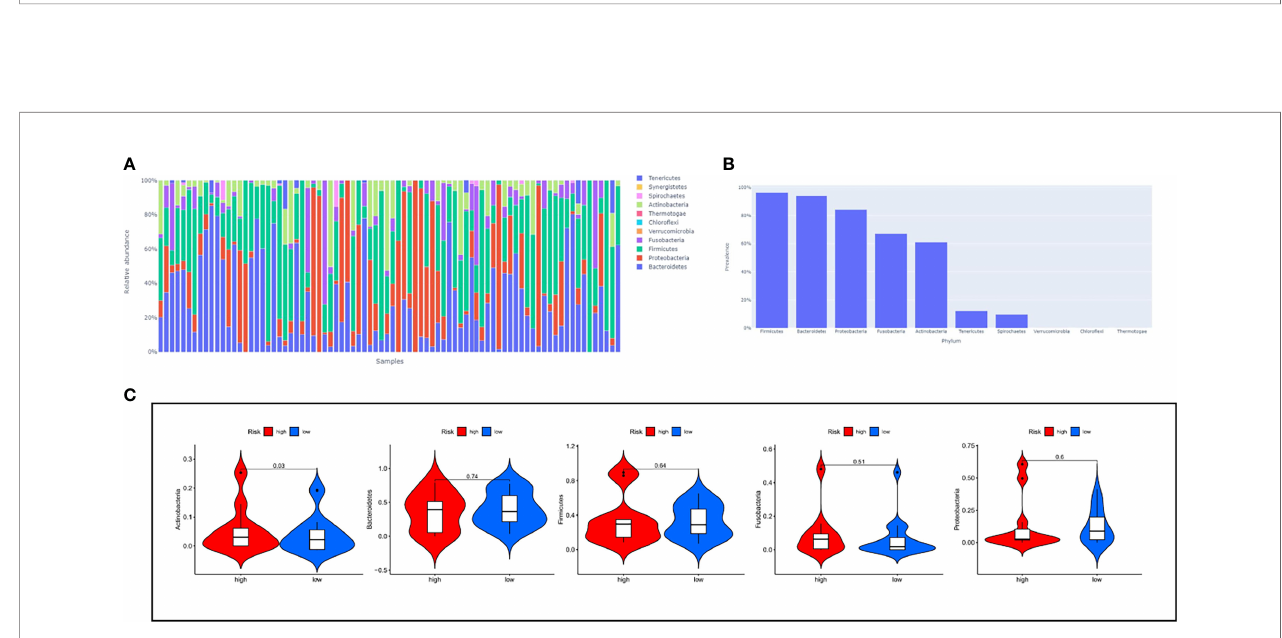
FIGURE 8 | The low- and high-risk groups display different immune landscape, expression levels of immune checkpoint genes, and chemotherapy drug sensitivity. (A) Heat map showing the difference in the immune landscape between the low- and high-risk groups. (B) The expression levels of immune checkpoint genes between high- and low-risk groups. (C) The boxplot of sensitivity of common chemotherapy drugs between high- and low-risk groups. ns, not signi fi cant, * P < 0.05, ** P < 0.01.